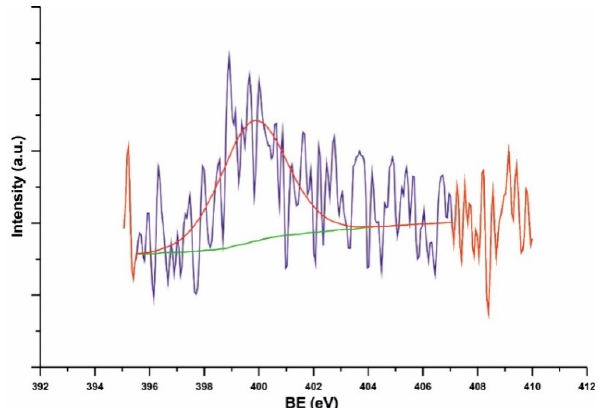
Figure 9. High resolution X-ray photoelectron spectroscopy (XPS) of Nanocyl NC7000 TM MWCNTs obtained in the N 1s bonding energy region for N -arylated MWCNTs.